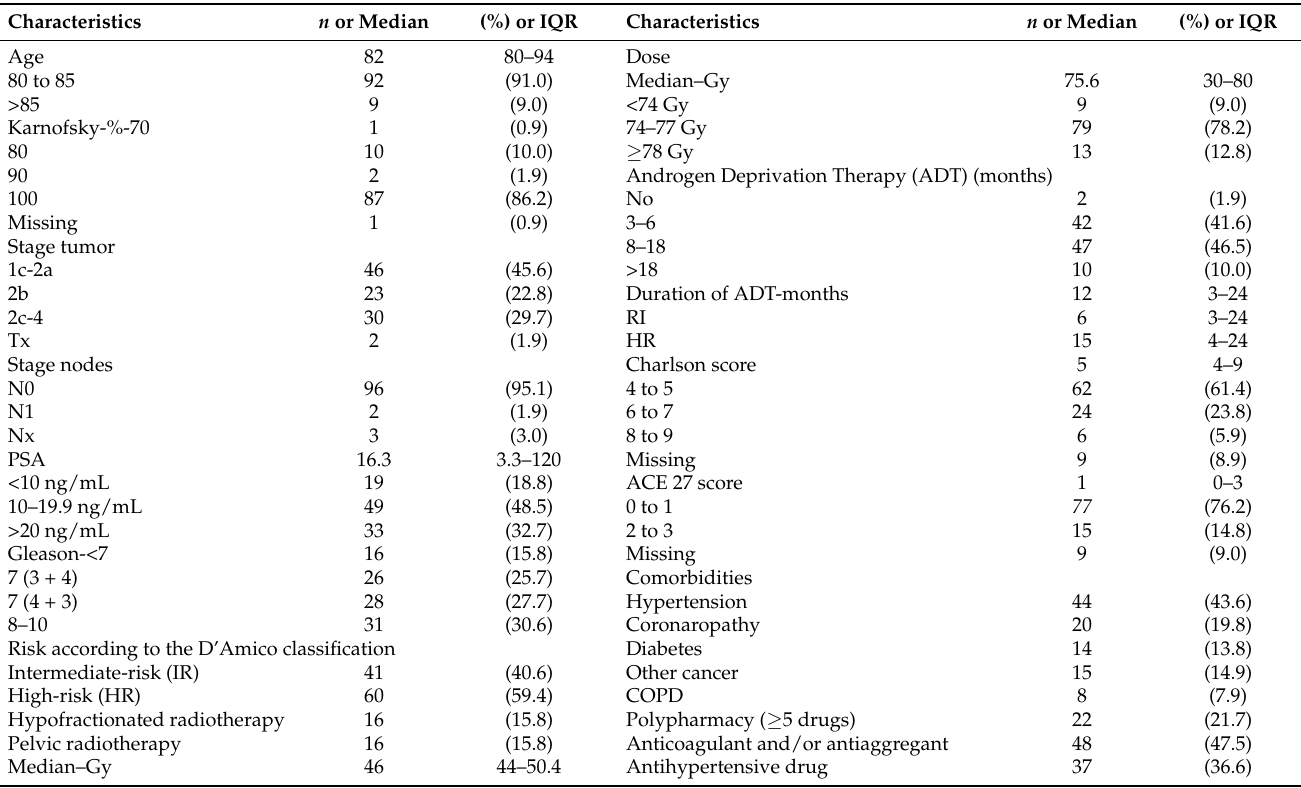
Table 1. Demographic, medical, and oncologic characteristics of 101 older patients.